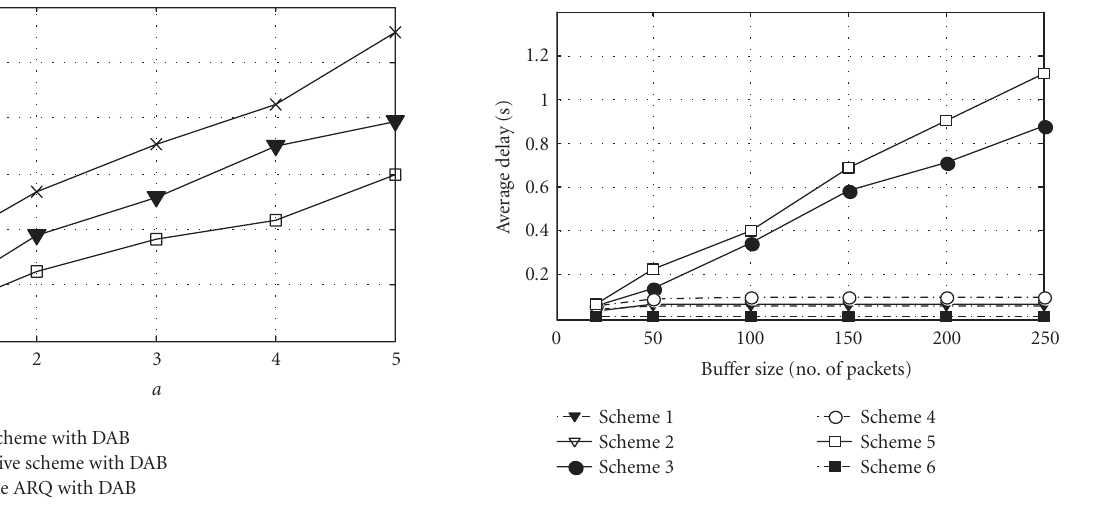
Figure 7: Mean packet loss rates for three DAB-based schemes, with changing channel conditions.